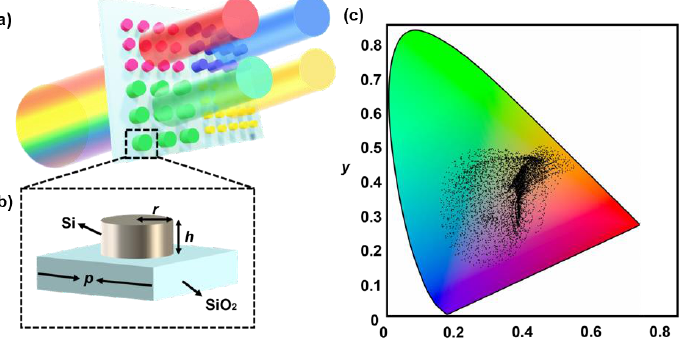
Figure 1. ( a ) Schematic of the SCFs illustrating the color filter effect. ( b ) Single nanopillar as metasur- face unit cell of the SCF. ( c ) The coverage of generated colors by SCF on the CIE 1931 chromatic diagram.